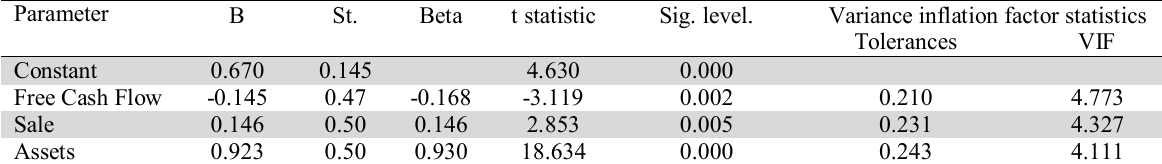
Test results of the linear independence of the independent variables Parameter B St. Beta t statistic Constant